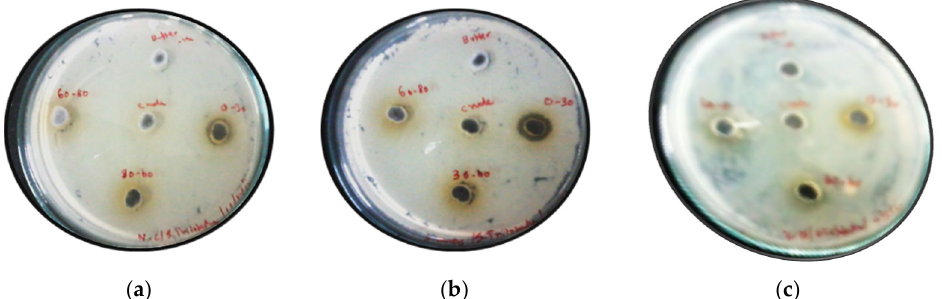
Figure 1. Antibacterial activity of fractionated Solanum trilobatum proteins against Vibrio cholerae , Staphylococcus aureus and Eshersia coli , respectively . ( a – c ) Centre well—Extracted aqueous crude, Right well—0–30% fraction, Left well—60–80% fraction, Top well—Extraction Buffer (control), Bottom well—30–60% fraction.